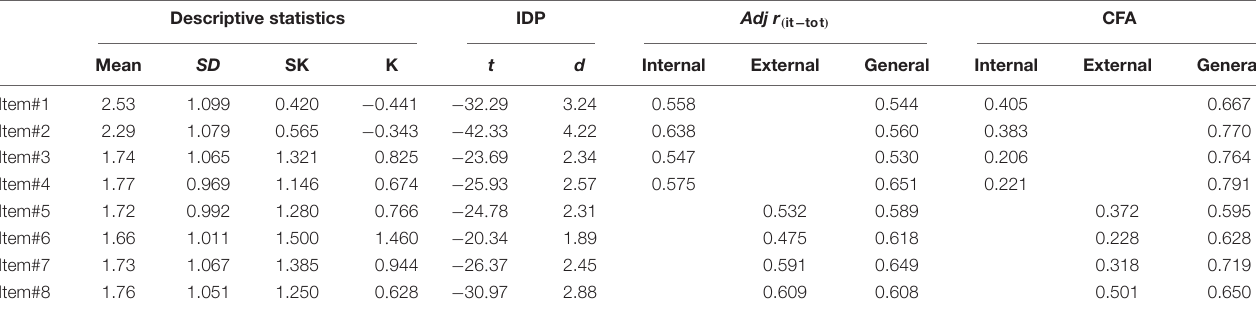
TABLE 2 | Study 2. Item descriptive statistics, item psychometric properties, and factor loadings ( λ ) of the confirmatory factor analysis (CFA).